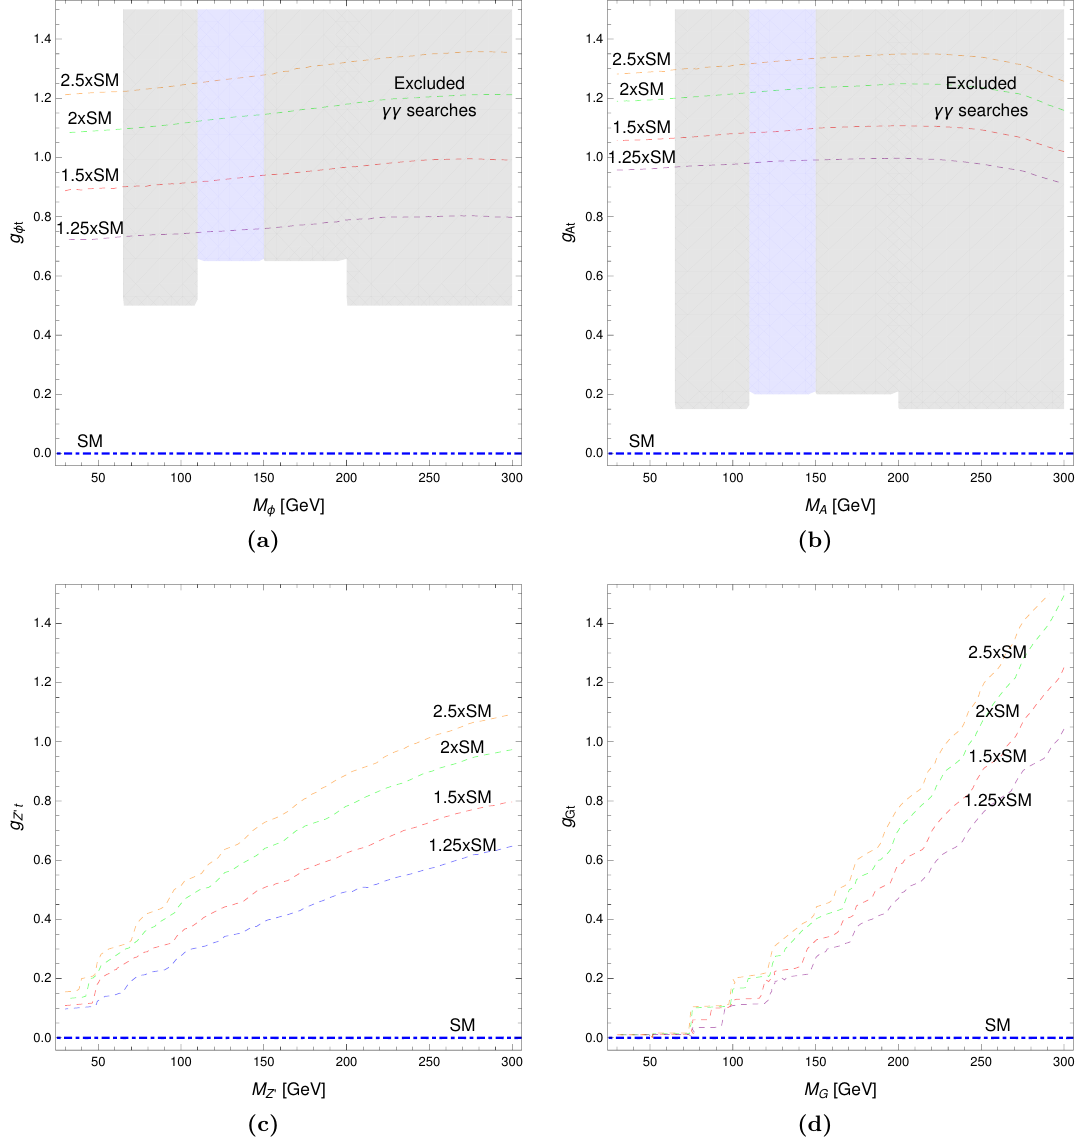
Figure 2. Four-top production cross-section contour levels (in units of the SM cross-section) in the plane of coupling strength versus resonance mass for the di(cid:11)erent NP models considered; (a) Scalar, (b) Pseudo-scalar, (c) Z 0 and (d) Graviton. The Z 0 and Graviton models exhibit a larger four-top production cross-section dependence on the resonance mass since the NP is coupled to an unconserved current, as explained in the text. Values of the predicted cross-section above about 2 SM are excluded at the 95% CL by the latest four-top search at the LHC (under the assumption (cid:2) of SM kinematics). The gray shaded area represents the region excluded by (cid:13)(cid:13) resonance searches. The light-blue shaded region corresponds to an interpolation since there are not available general (cid:13)(cid:13) searches in the 110 GeV{150 GeV range, where the H (cid:13)(cid:13) signal is measured and no other ! excesses are observed. In the case of the Z 0 and Graviton models, such (cid:13)(cid:13) resonance searches do not yield signi(cid:12)cant constraints: the Z 0 resonance cannot decay into (cid:13)(cid:13) , whereas the Graviton model considered is less sensitive to (cid:13)(cid:13) searches as explained in the text.